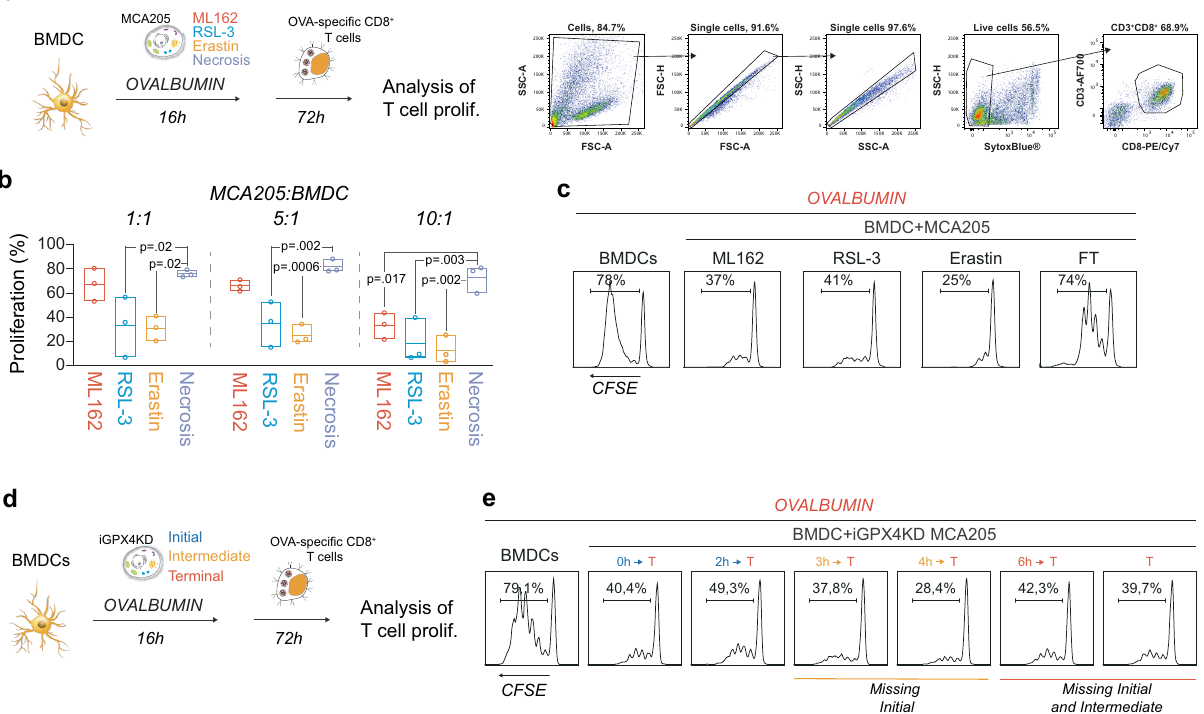
Fig. 5 Ferroptotic cells impair dendritic cells ability to perform antigen cross-presentation. a Bone marrow-derived dendritic cells (BMDC) were incubated with soluble OVA in the presence of ferroptotic (ML162 0.5 µ M, 14 h; RSL-3, 0.5 µ M, 14 h; Erastin 2.0 µ M, 24 h) or necrotic (3 cycles of freeze/ thaw, FT) cancer cells. Afterwards, fl uorescently labeled OVA-speci fi c CD8 + cells, were added to the co-culture and their proliferation was assessed 72